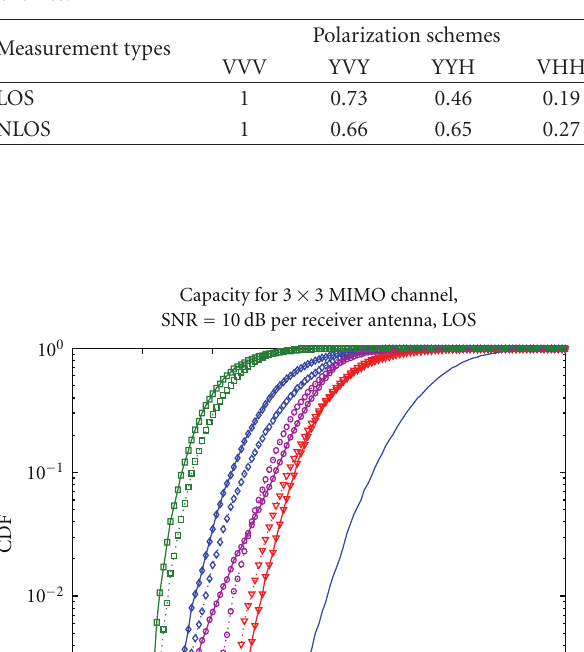
Table 8: Average normalized power for various polarization schemes.